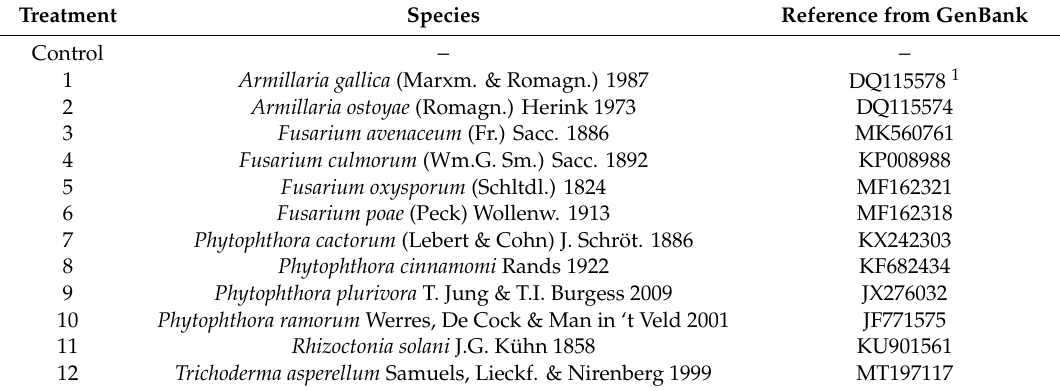
Table 2. General characteristics of the fungal and oomycete species tested in the experiment. Treatment Species Reference from